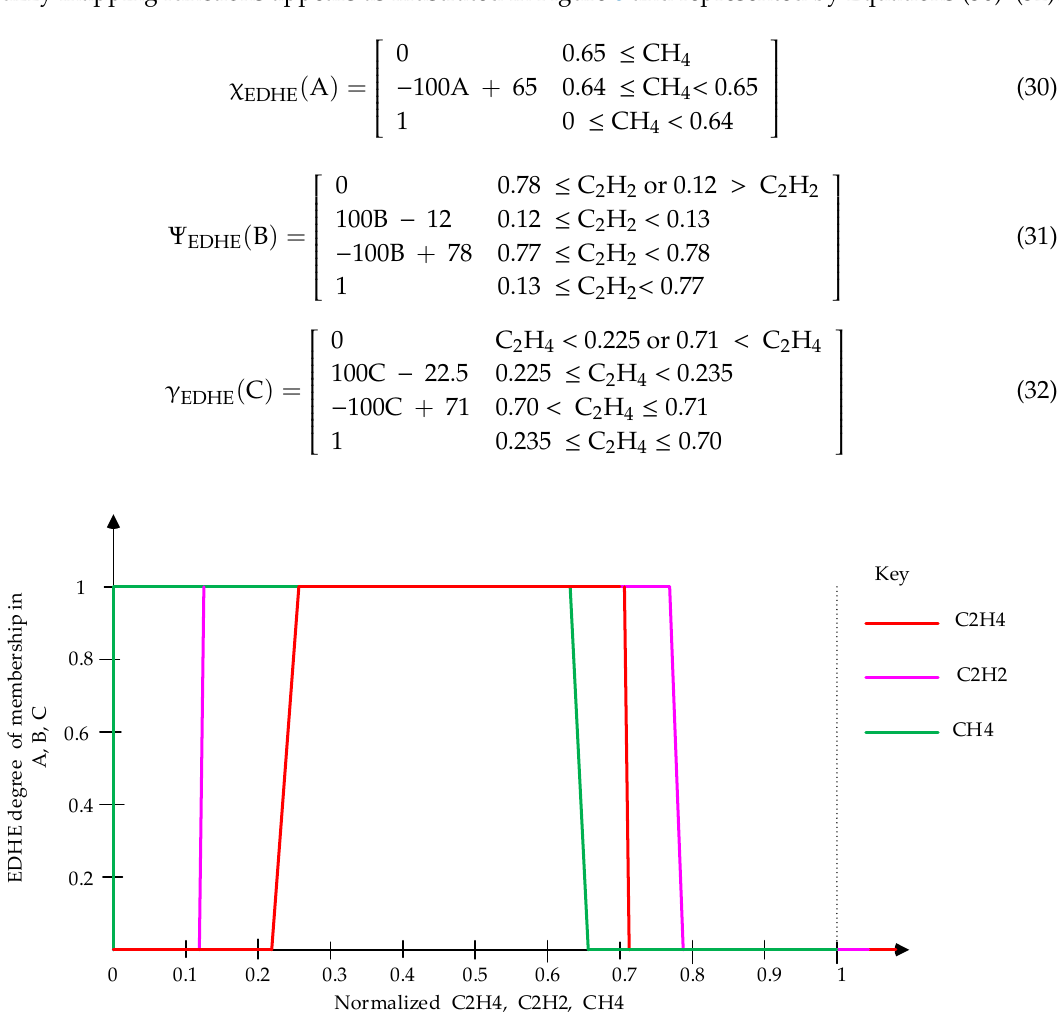
Figure 8. Characteristic curves for performing the presence of high-energy (EDHE) faults testing.